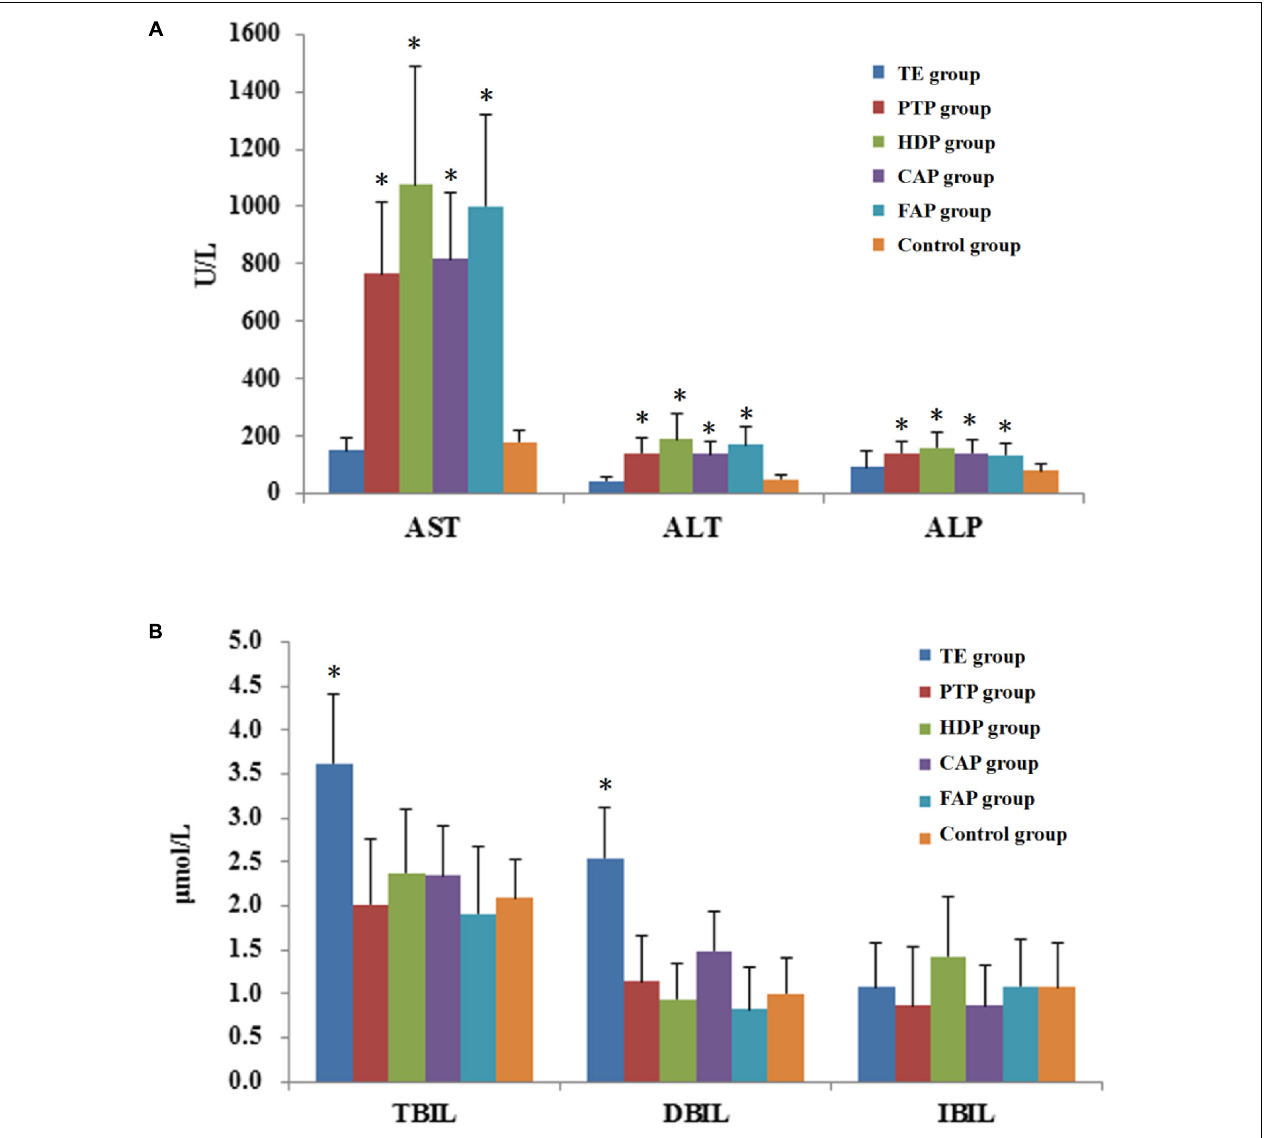
FIGURE 3 | The biochemical indexes in rat plasma after oral administrated different parts of Polygonum multiflorum. (A) : The level of ALT, AST and ALP; (B) : The level of TBil, DBil, and IBil. ∗ P < 0.05, comparison between the control group and treatment groups. (This data was published in Cell Physiol Biochem